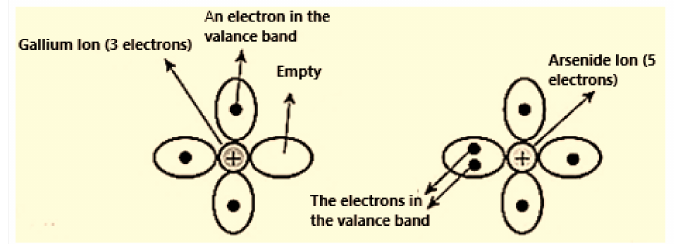
Figure 8. The structure of valence electrons of Ga and As